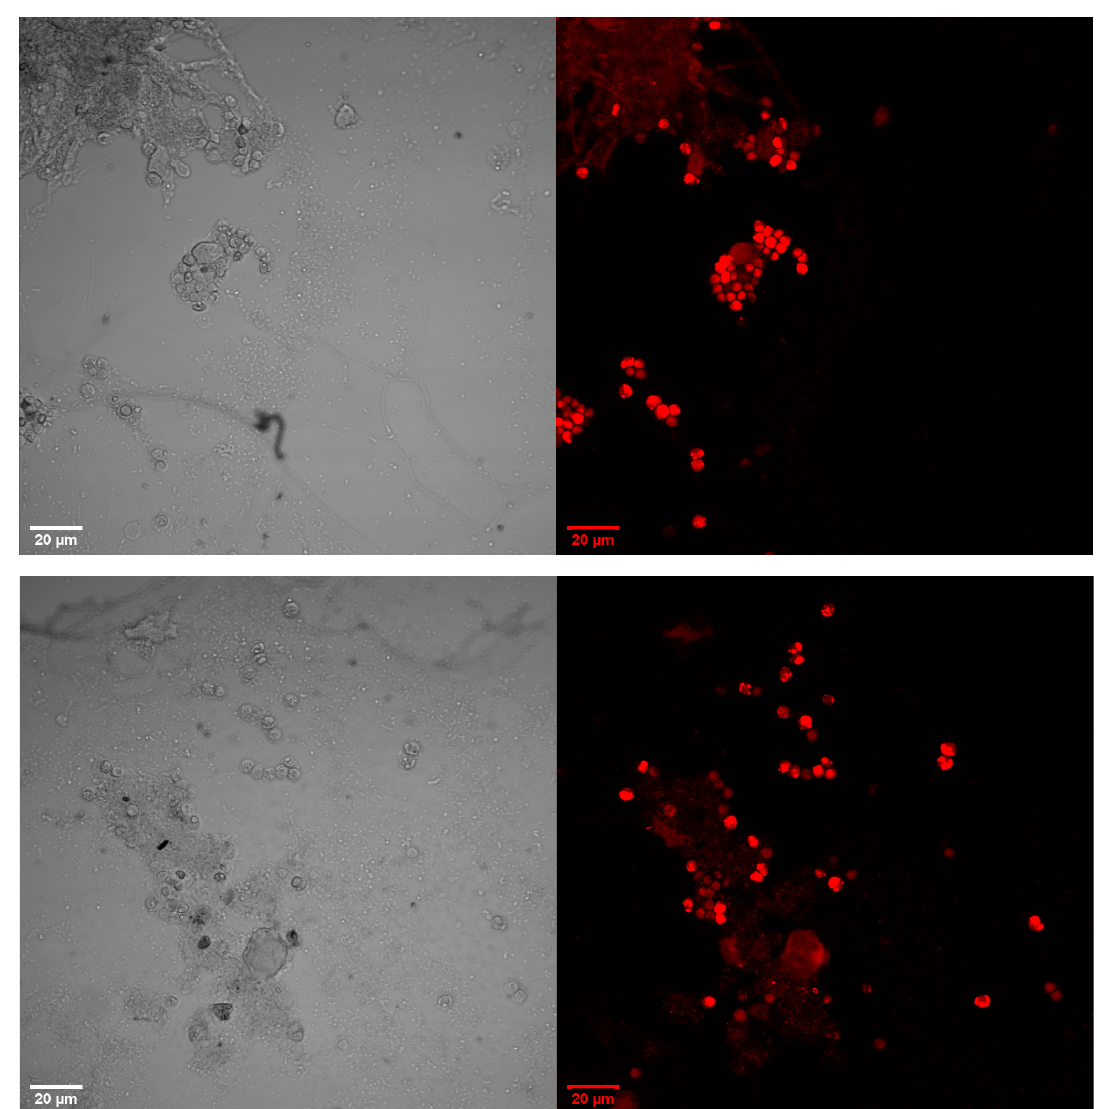
Figure A1. Microscopic images (objective 60×) of samples (batch reactor) observed in visible light and after using Nile Blue A procedure with red filter and blue laser excitation. Both photos were taken on day 66 of batch process and show variability in structure of PHB granules.